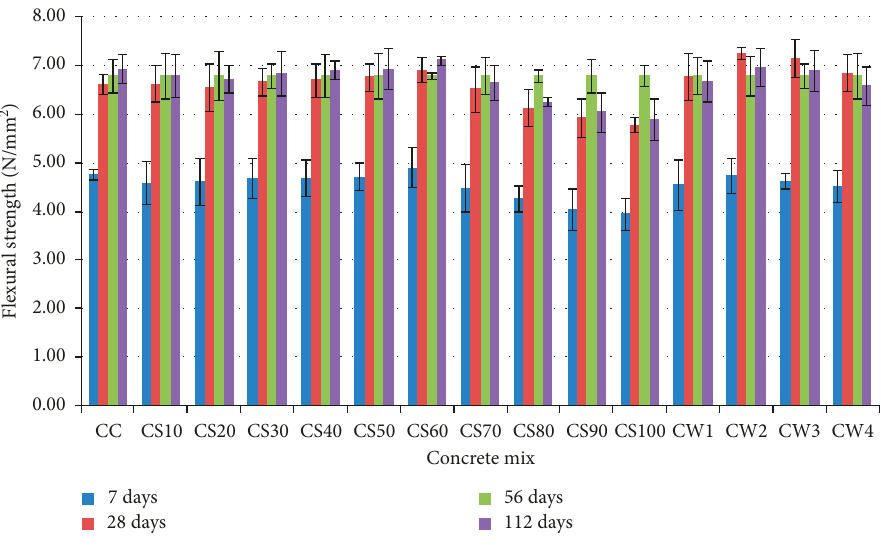
Figure 7: Flexural strength of concrete mixes at different curing ages.